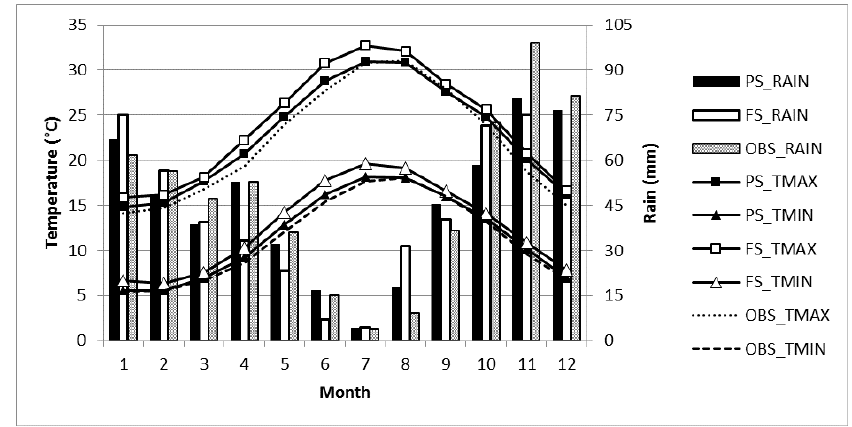
Figure 5. Observed and synthetic generated climate values for 150 years: average values of maximum and minimum temperatures (TMAX, TMIN) and precipitation (RAIN) for current and future scenarios (PS, FS).